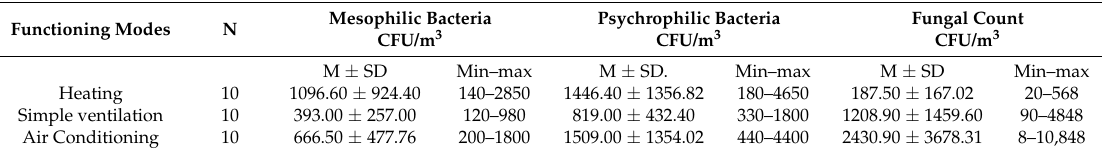
Total microbial concentrations measured in gyms during heating, air conditioning, and simple ventilation.